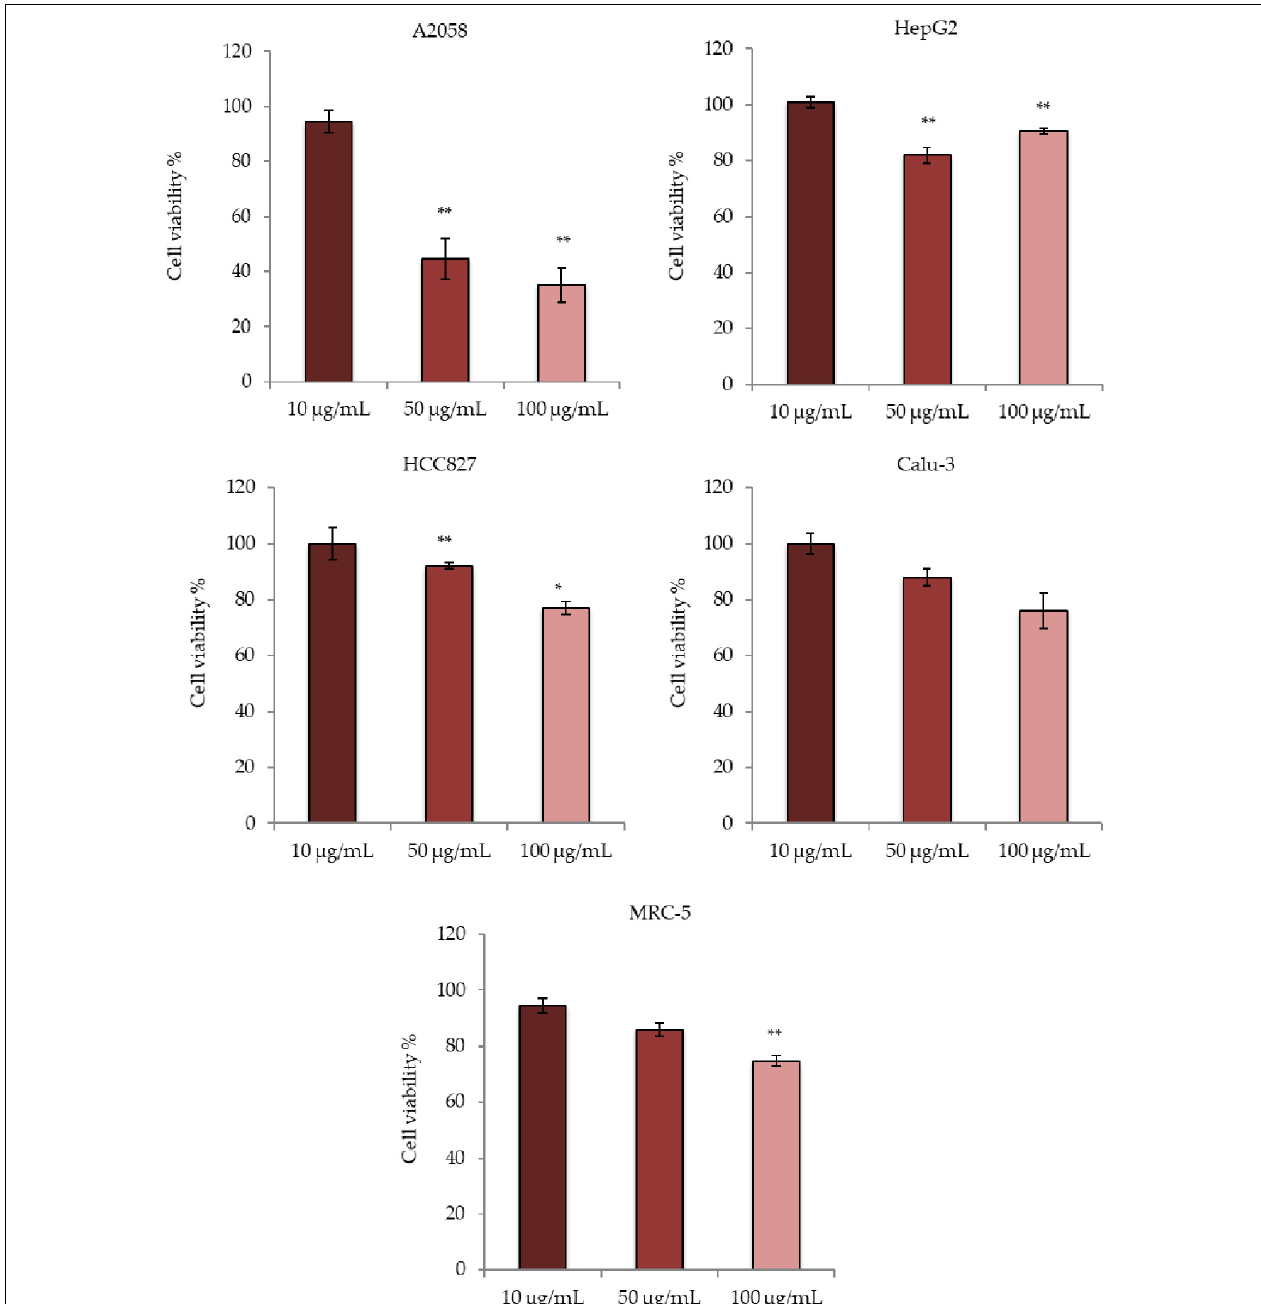
FIGURE 1 | Antiproliferative effects of Dunaliella tertiolecta raw extract on A2058, HepG2, HCC827, Calu-3, and MRC-5 cell lines. Results are expressed as percentage of cell survival after 72 h exposure ( n = 3). Cell growth was expressed as the percentage cell viability with respect to the vehicle (DMSO) for each concentration. ** p < 0.01, * p < 0.05 vs. untreated